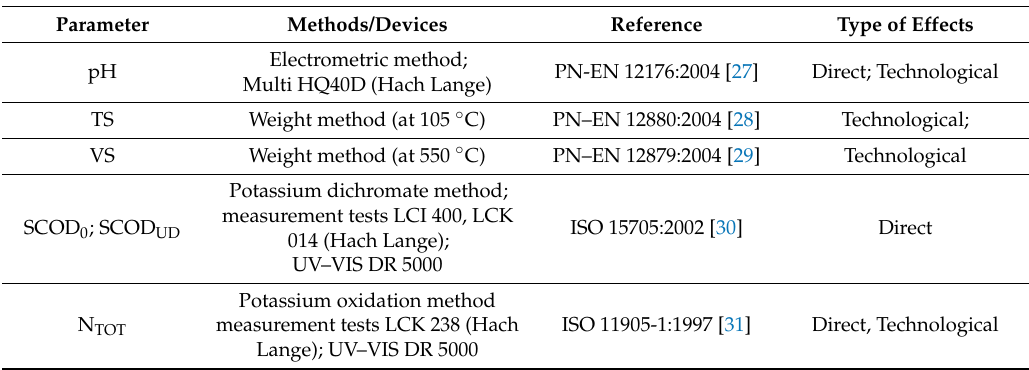
Table 2. The list of methods used in this